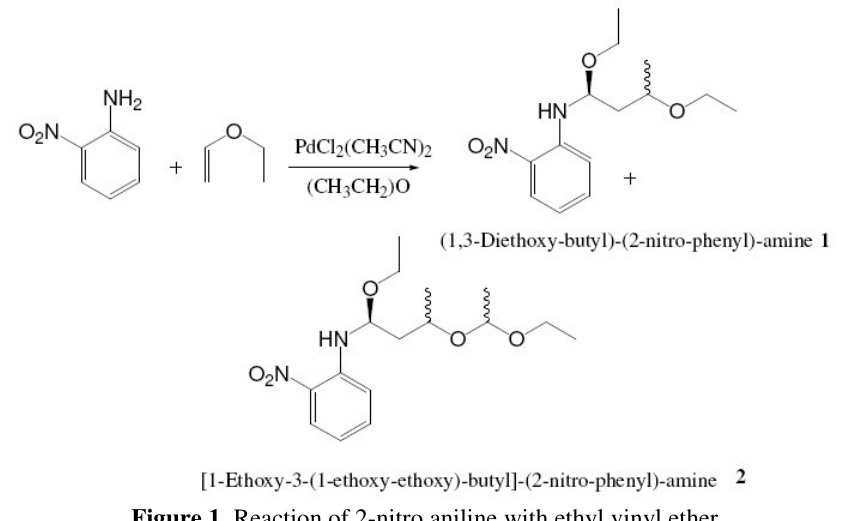
Figure 1. Reaction of 2-nitro aniline with ethyl vinyl ether